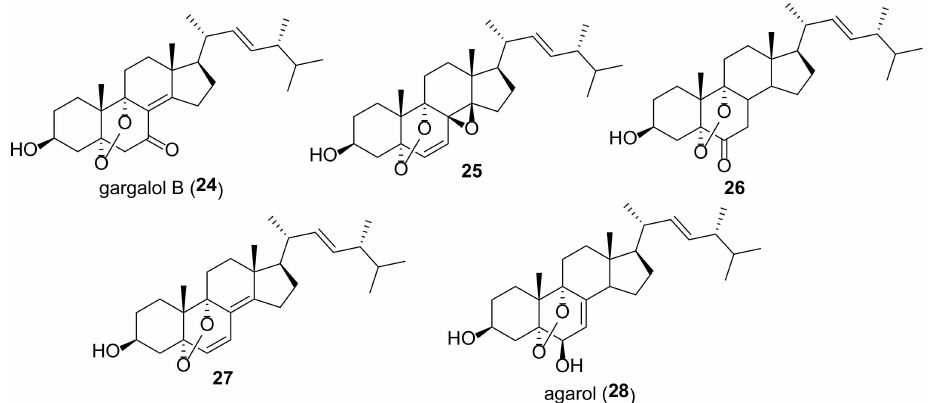
Figure 6. Structures of fungal 5 α ,9 α